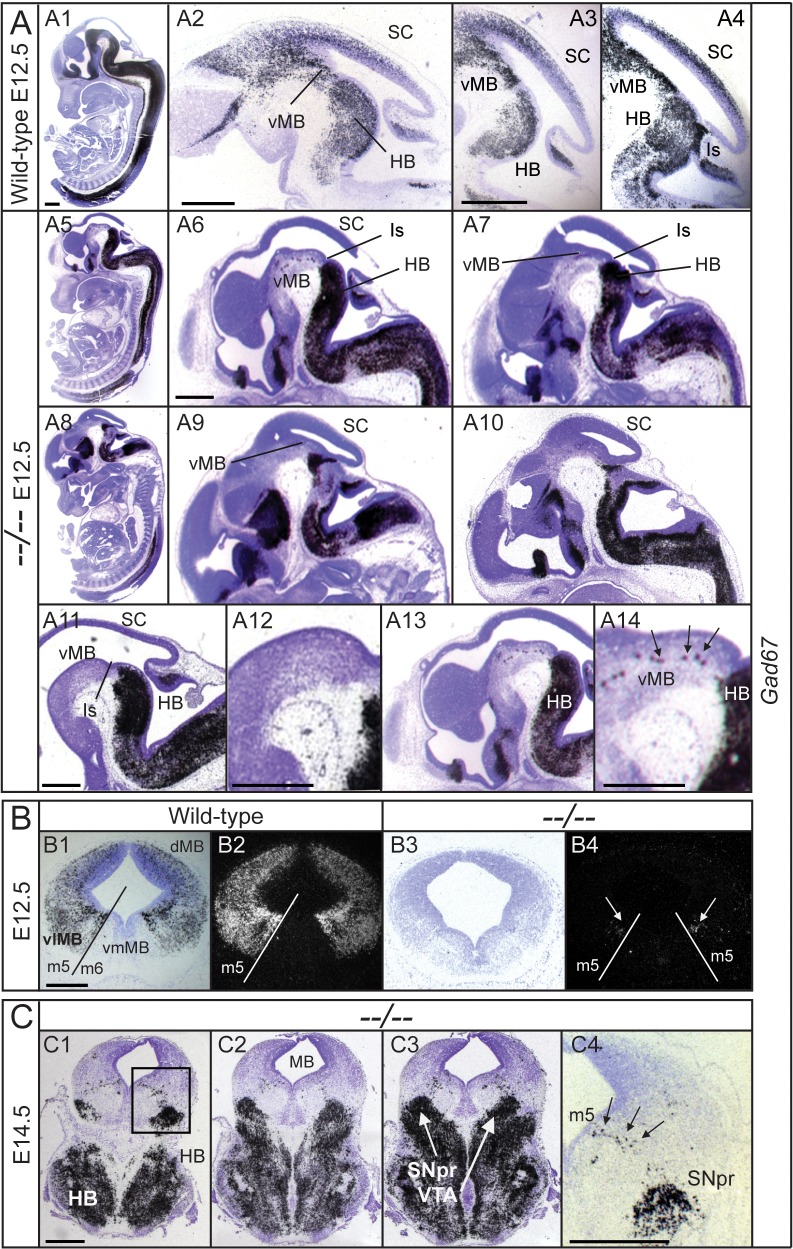

Mgn and Mash1 were necessary and sufficient to induce GABAn in the MB.Phenotypic analysis of Mgn
−/−
Mash1
−/− (−−/−−) mice by ISH with the Gad67 riboprobe on sagittal (A) and coronal (B-C) sections, showing the mesencephalon at E12.5 and E14.5 from both wild-types (A1–A4; B1 and B2) and double mutants (with B5–B7 being representative slides from anterior to posterior). The arrows in A14, B4, and C4 indicate the presence of few Gad67 cells in the m5 domain (m5) at E12.5 and E14.5. Scale bars: 500 μm. Abbreviations: HB, hindbrain; Is; isthmus; SC, superior colliculus; SNpr, substantia nigra pars reticulata; vMB, ventral midbrain; VTA, ventral tegmental area.